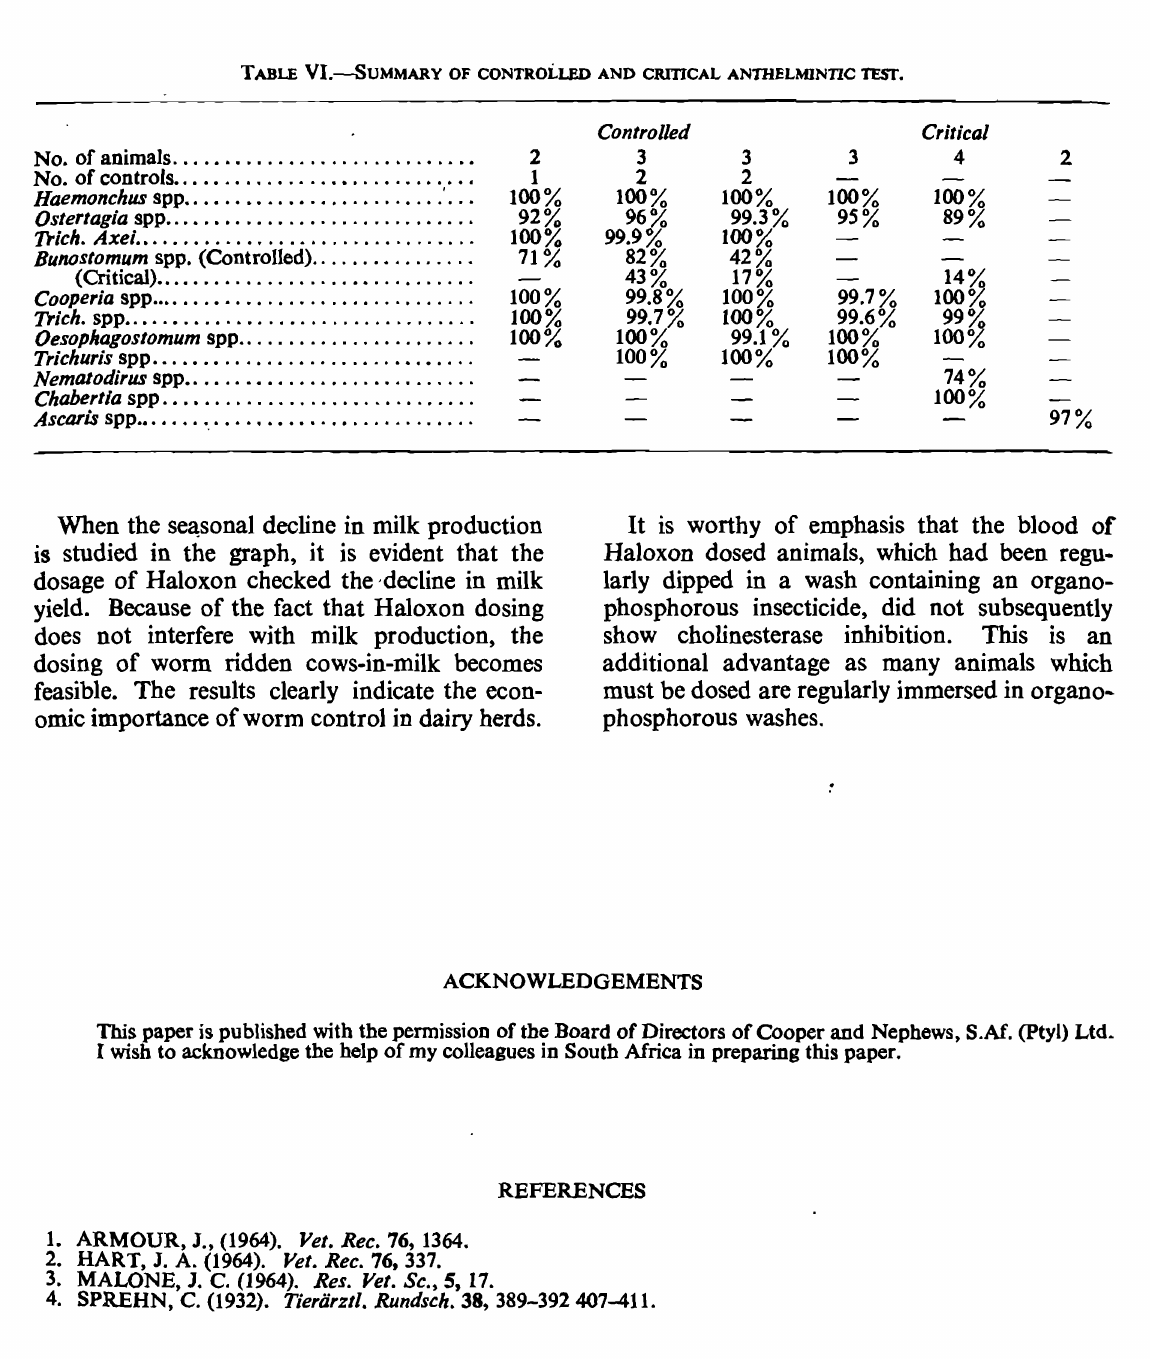
TABLE VI.-SuMMARY OF CONTROLLED AND CJU11CAL ANlHELMlNllC